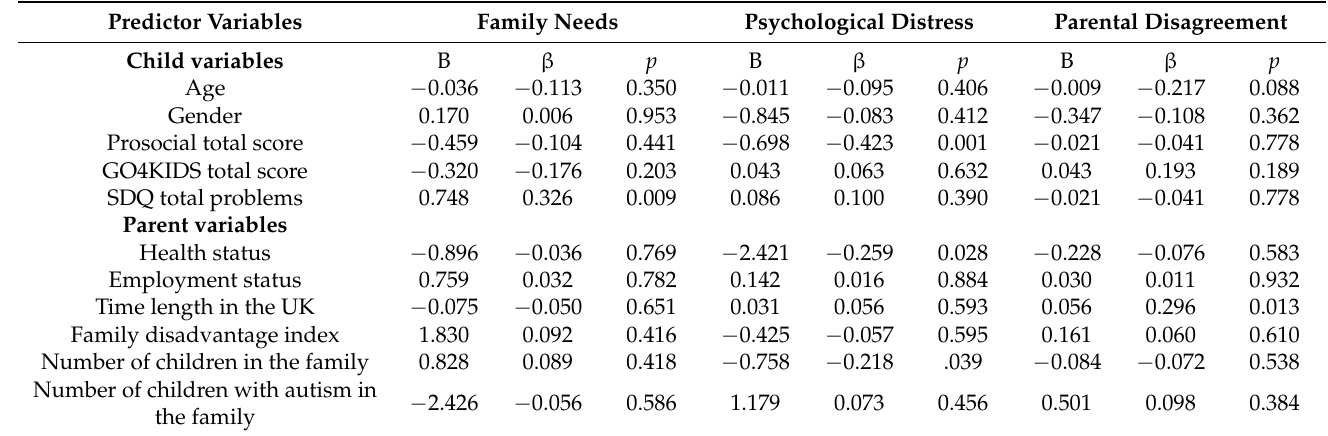
Table 3. Results of linear regression analysis of family needs, psychological distress, and